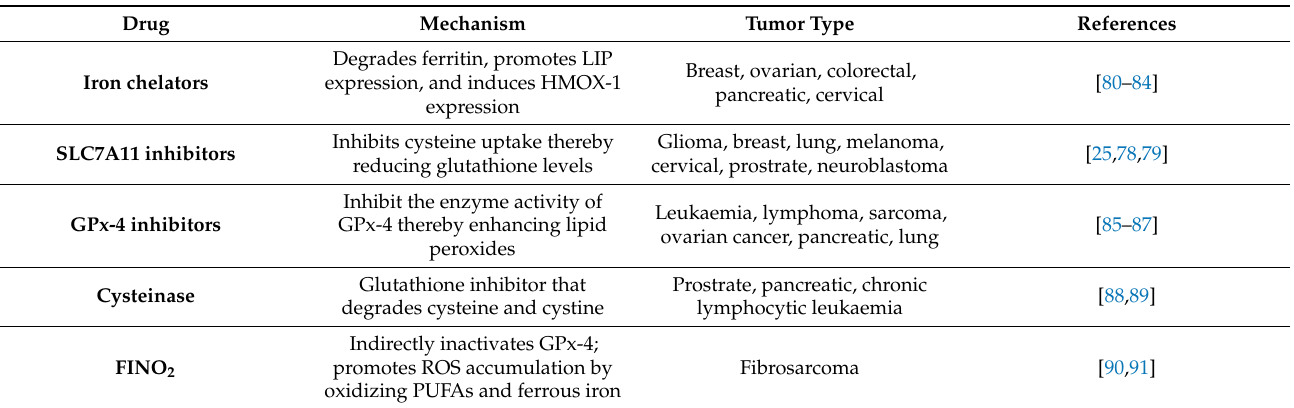
Table 2. Summarizes various drugs and their mechanism of action to induce ferroptosis in therapy- resistant